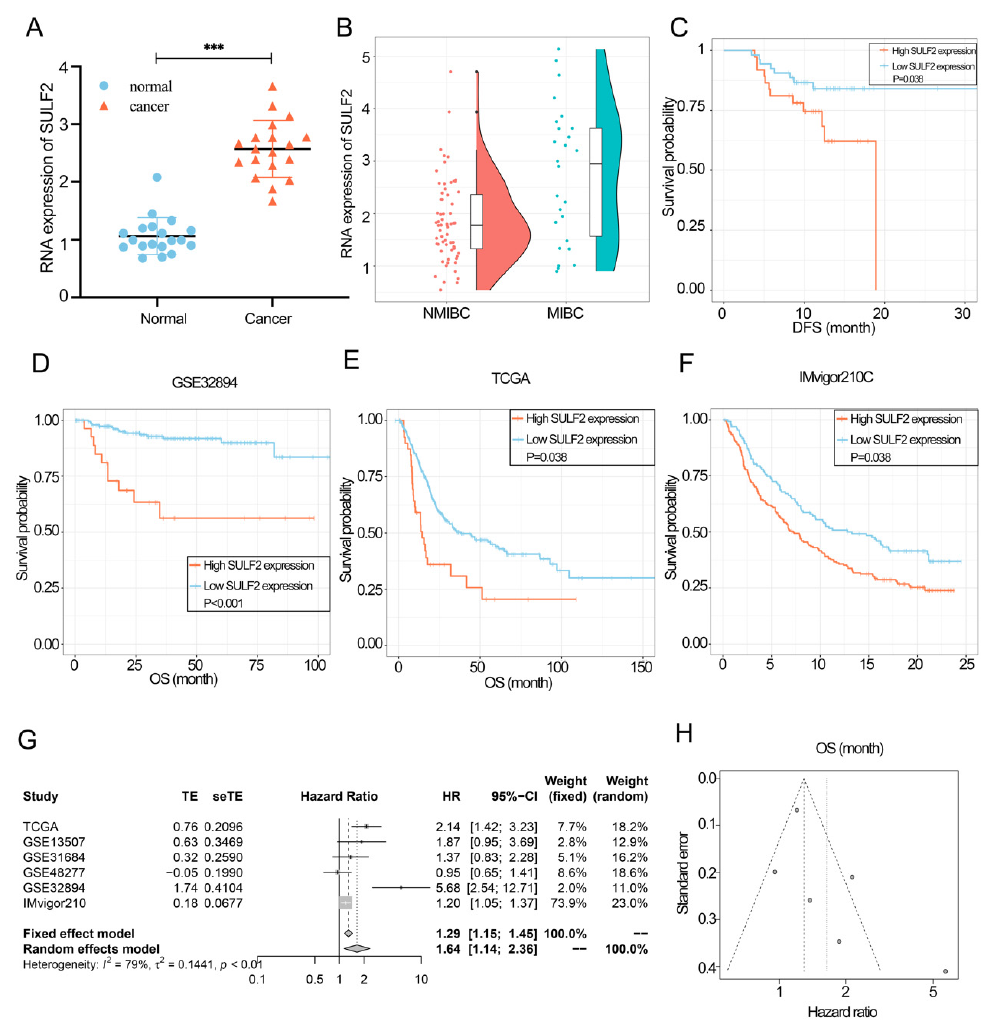
Figure 1. SULF2 is highly expressed in bladder cancer (BCa) and is associated with a poor prognosis. ( A ) SULF2 mRNA was detected in 20 pairs of BCa and adjacent normal tissues using qPCR. ( B ) The difference in SULF2 expression of NMIBC and MIBC was observed by RNA sequencing of BCa tissues obtained from 90 patients with BCa. ( C ) Kaplan–Meier analysis of DFS for 90 patients with BCa with low or high SULF2 expression level. ( D – F ) Kaplan–Meier analysis of OS for patients BCa with low or high SULF2 expression level in GSE32894, TCGA, and IMvigor210C dataset. ( G , H ) Meta-analysis verified the correlation between SULF2 expression and OS in six datasets. Data are represented as mean ± SD of three experiments. *** p <